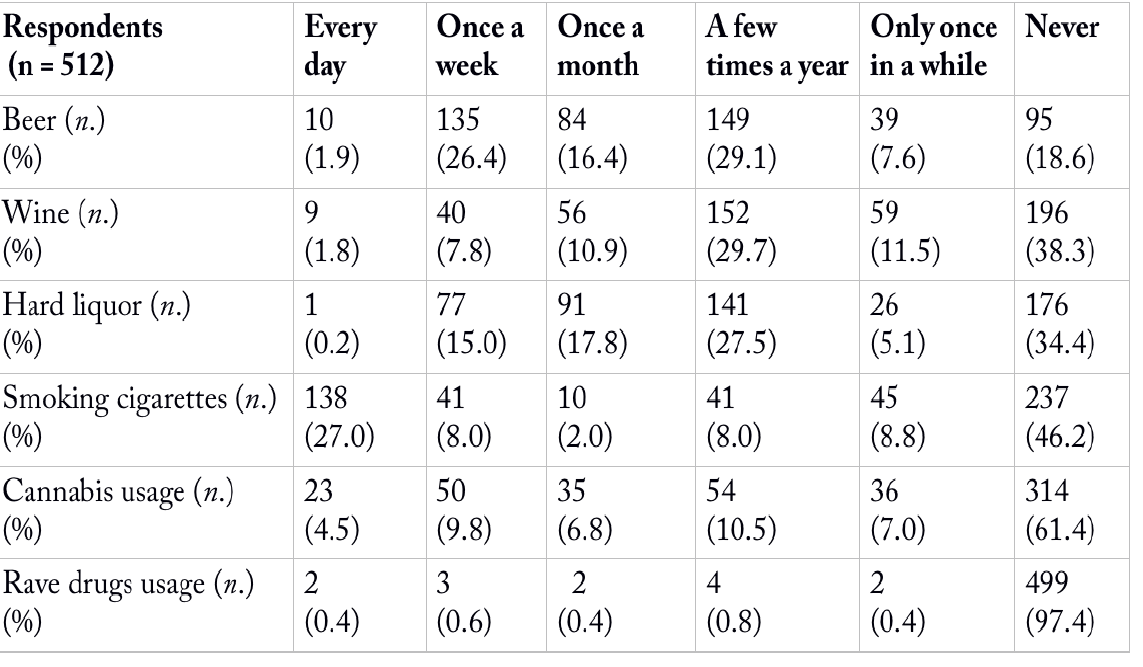
Table 1 . Prevalence of alcohol and psychoactive drugs intake assumption in the last